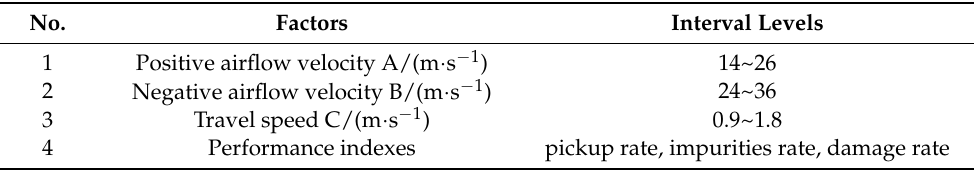
Table 2. Factors and interval levels for the performance evaluation tests of the positive and negative synergistic airflow-type jujube fruit harvester (P-N JH). No.